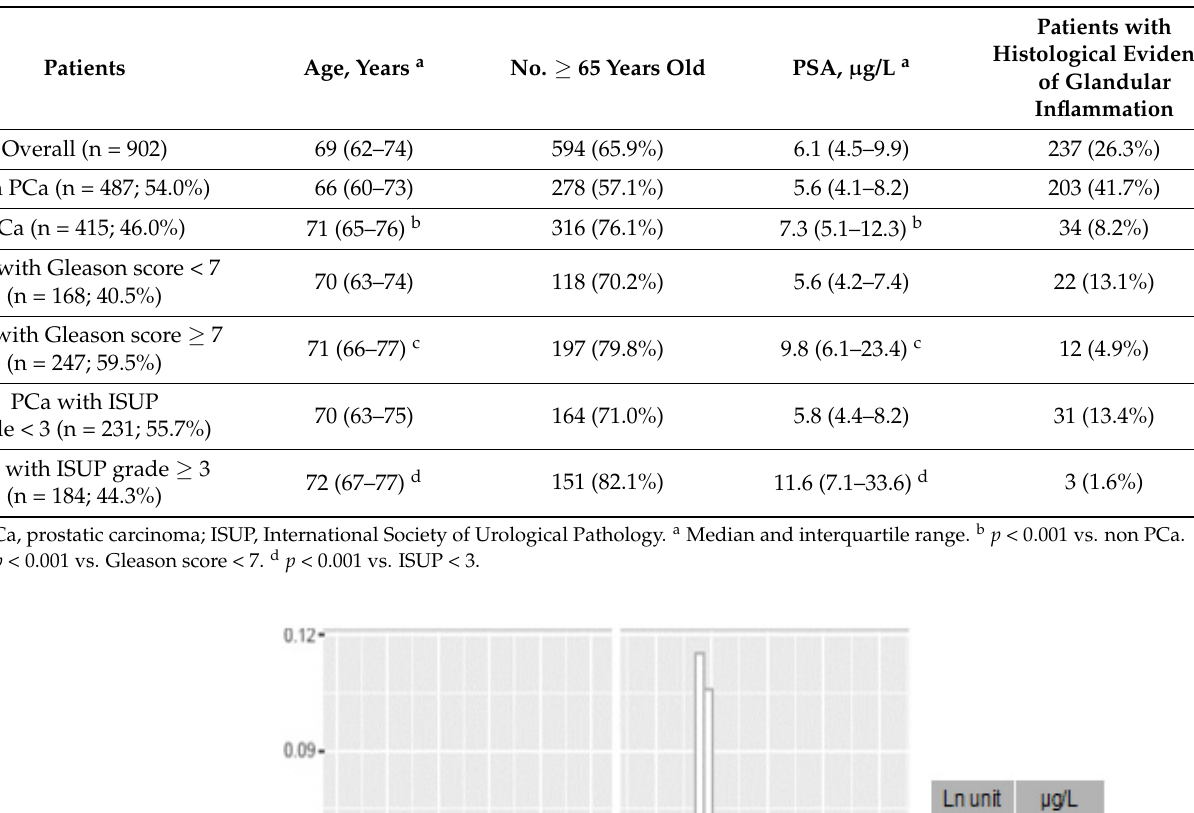
Table 1. Main characteristics of the studied case series.